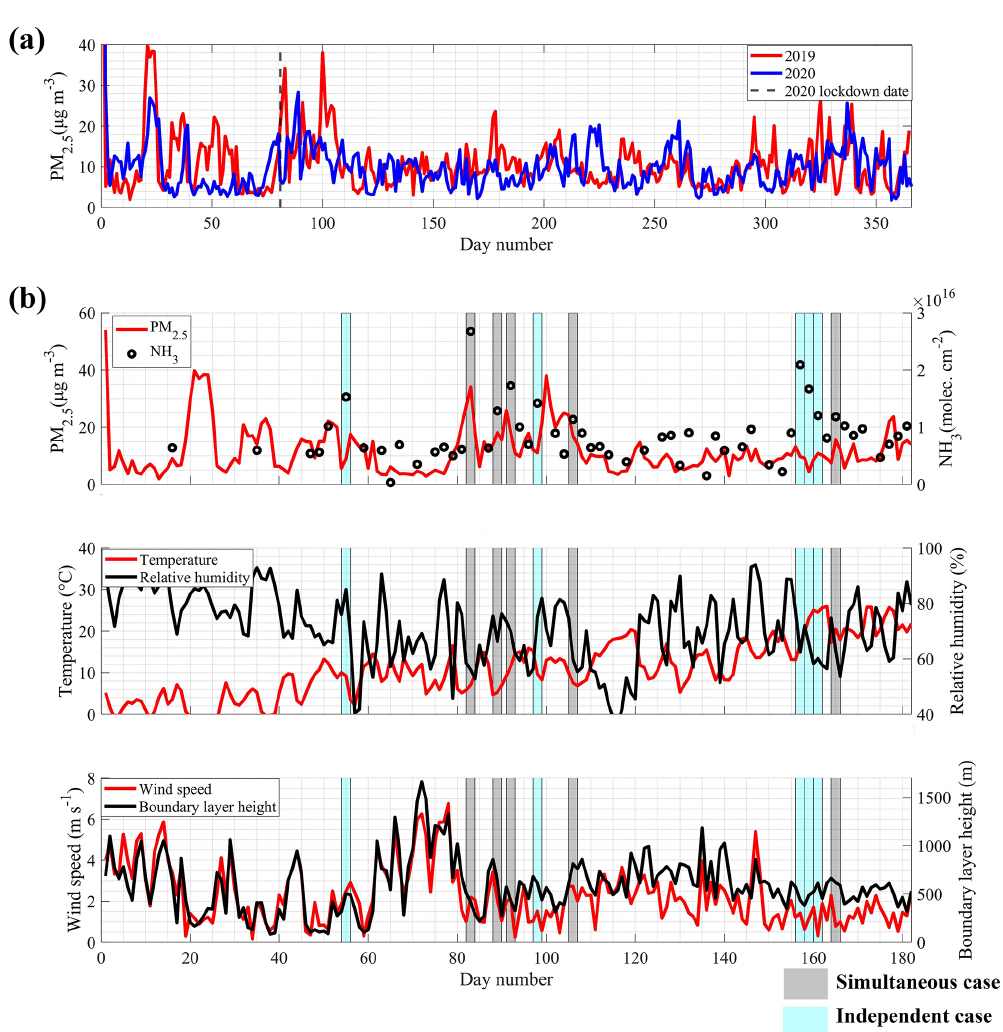
Figure 8. The 2019 and 2020 annual daily mean in situ PM 2 . 5 concentrations in Munich (a) . In panel (a) , the vertical dashed line denotes the start of the 2020 lockdown. The 2019 daily mean in situ PM 2 . 5 and column NH 3 from the IASI satellite ( b , top). The 2019 daily mean temperature and relative humidity ( b , middle). The 2019 daily mean wind speed and boundary layer height ( b , bottom). The corresponding days for the cases in Simultaneous are shaded with gray, and the cases in Independent are shaded with cyan. Simultaneous – simultaneous increase in NH 3 (IASI) and PM 2 . 5 (in situ) concentrations on the same day. Independent – increase in NH 3 (IASI) concentration not corresponding to an increase in PM 2 . 5 (in situ) concentration on the same